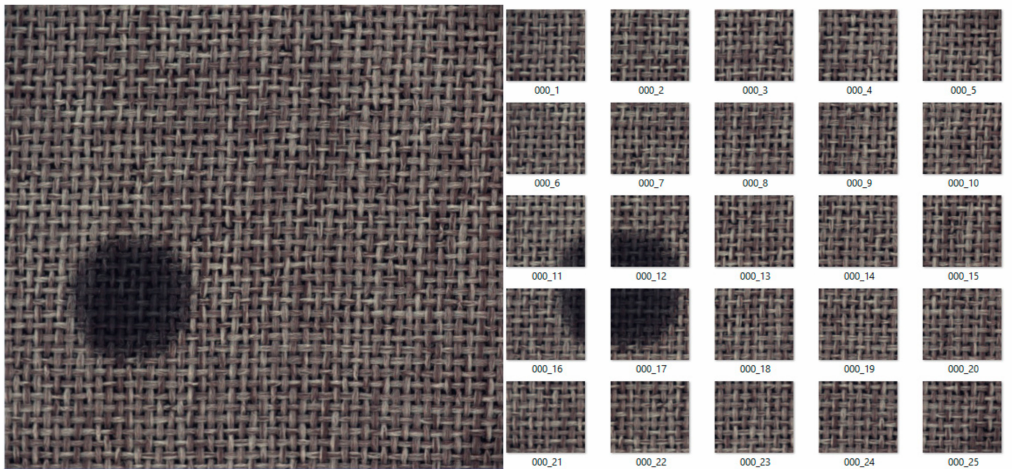
Figure 6. Subdivision of images for the carpet texture.